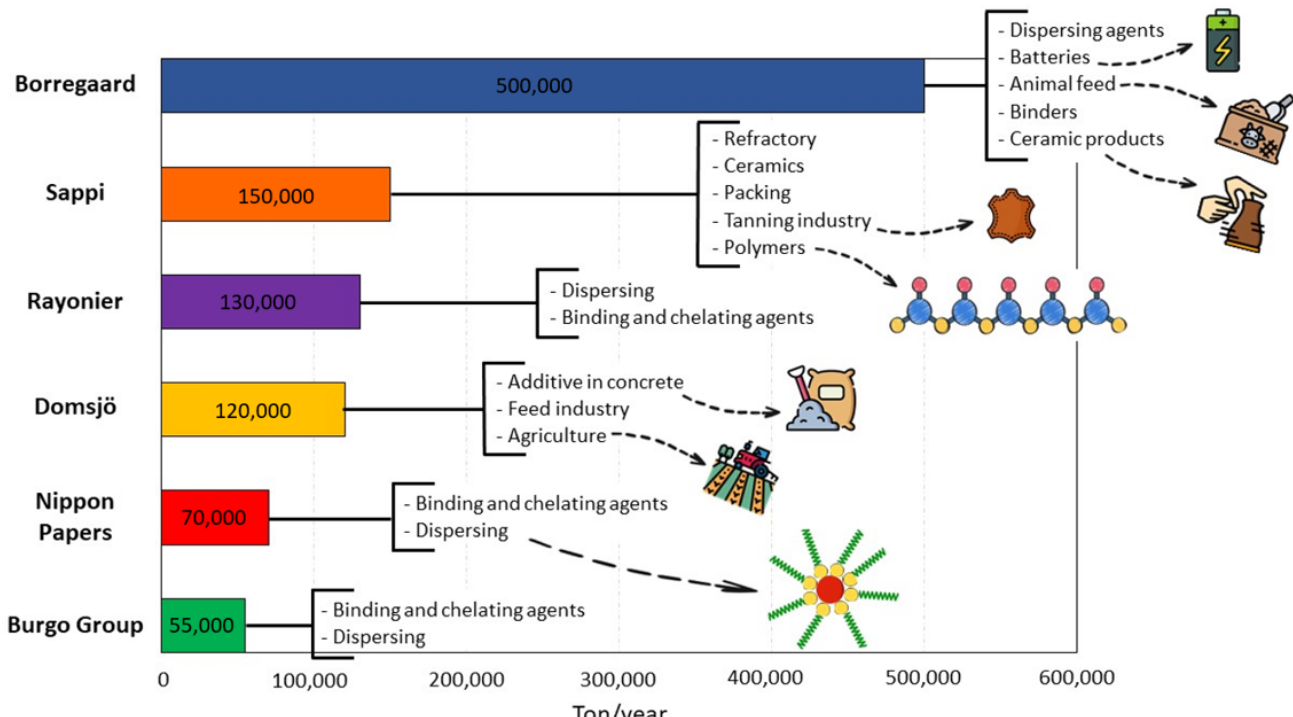
Figure 10. Commercial lignin brands and their applications.